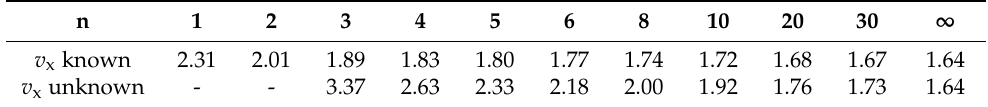
Table 7. Values of k n for the 5% characteristic value (PN-EN 1990 [23,26]). n 1